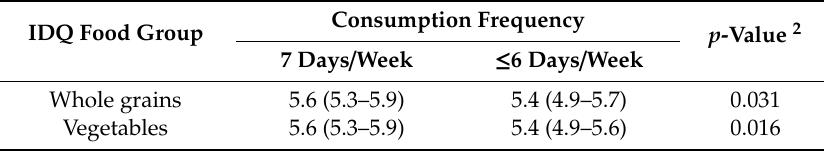
Table 4. Di ff erence in Shannon index according to frequency of food consumption 1